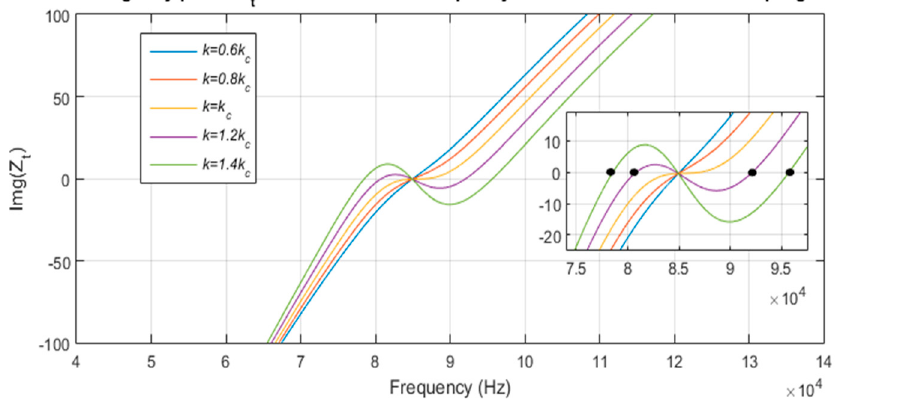
Figure 8. Evolution of the imaginary part of the impedance seen from the ground side as a function of the frequency for different values of the coupling coefficient and for a fixed load.